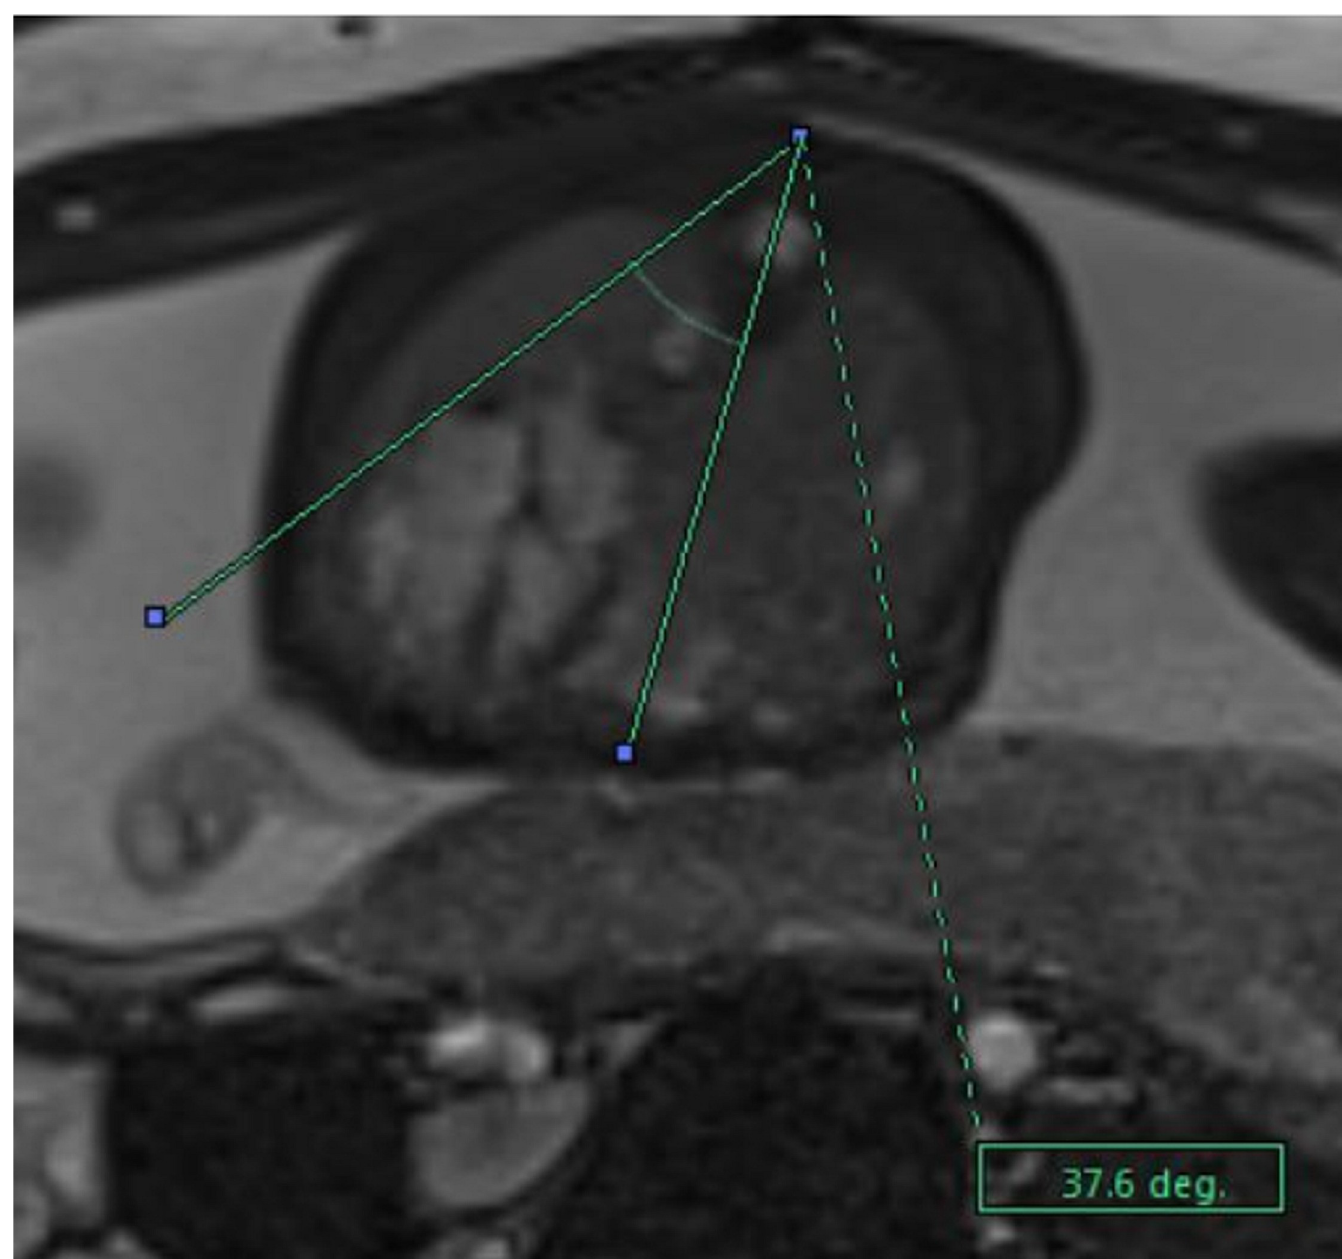
Fig 5. Mediastinal shift angle. MRI calculation of the mediastinal shift angle (MSA) on axial TrueFisp-sequences.